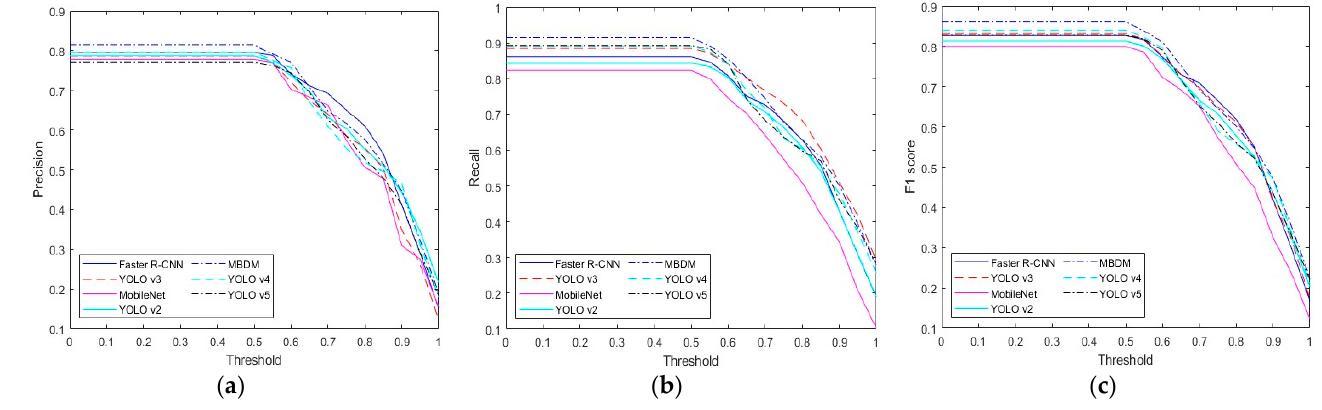
Figure 11. Performance comparison graph for each method according to IoU threshold in JOD database: ( a ) precision, ( b ) recall, and ( c ) F1 score.